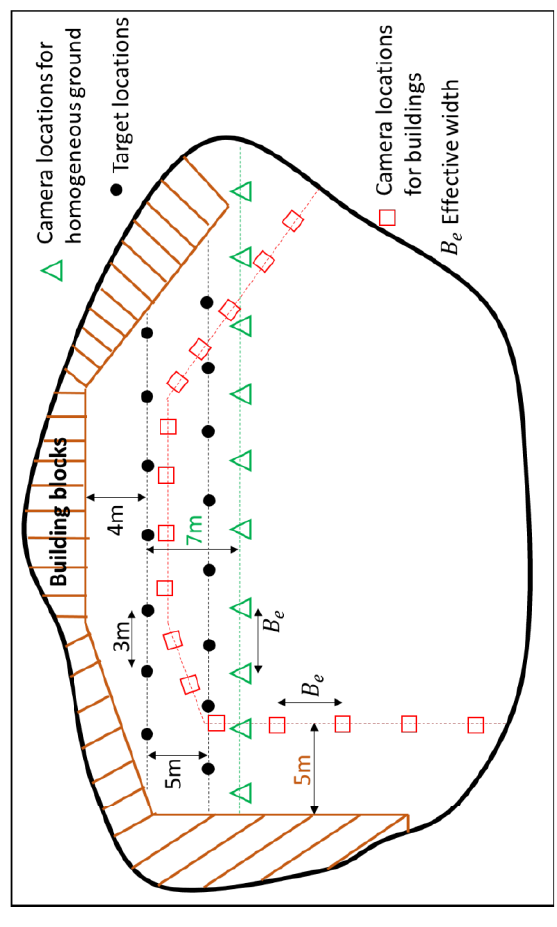
Figure 4. Schematic representation of the targets and camera positions